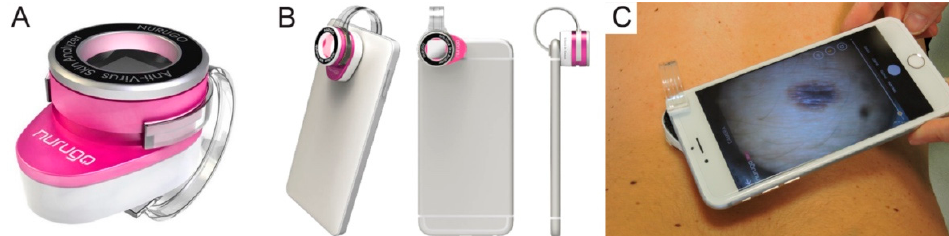
Figure 2. ( A ) Nurugo TM Derma; ( B ) Nurugo TM Derma attached to the smartphone; ( C ) Example of smartphone microscope applied to skin.